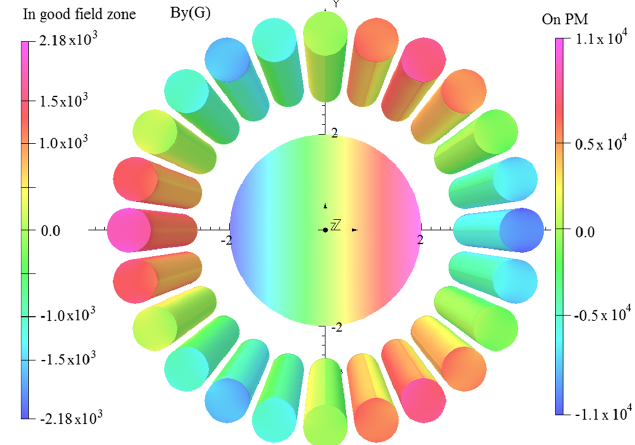
FIG. 21. The 3D arrangement of 24 PMs in a quadrupole magnet and the field in Gauss (G) in the good field zone at the center of the magnet ( Z ¼ 0 ). Field patterns in Gauss in the PM blocks are also shown. Half symmetry of the model is used for the